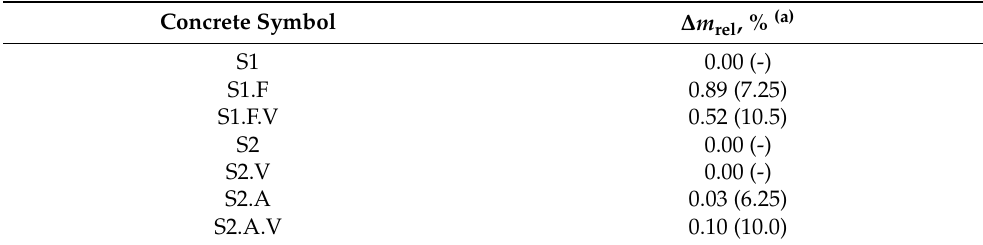
Table 5. Relative weight loss after 300 cycles of freezing and thawing, Δ m rel .